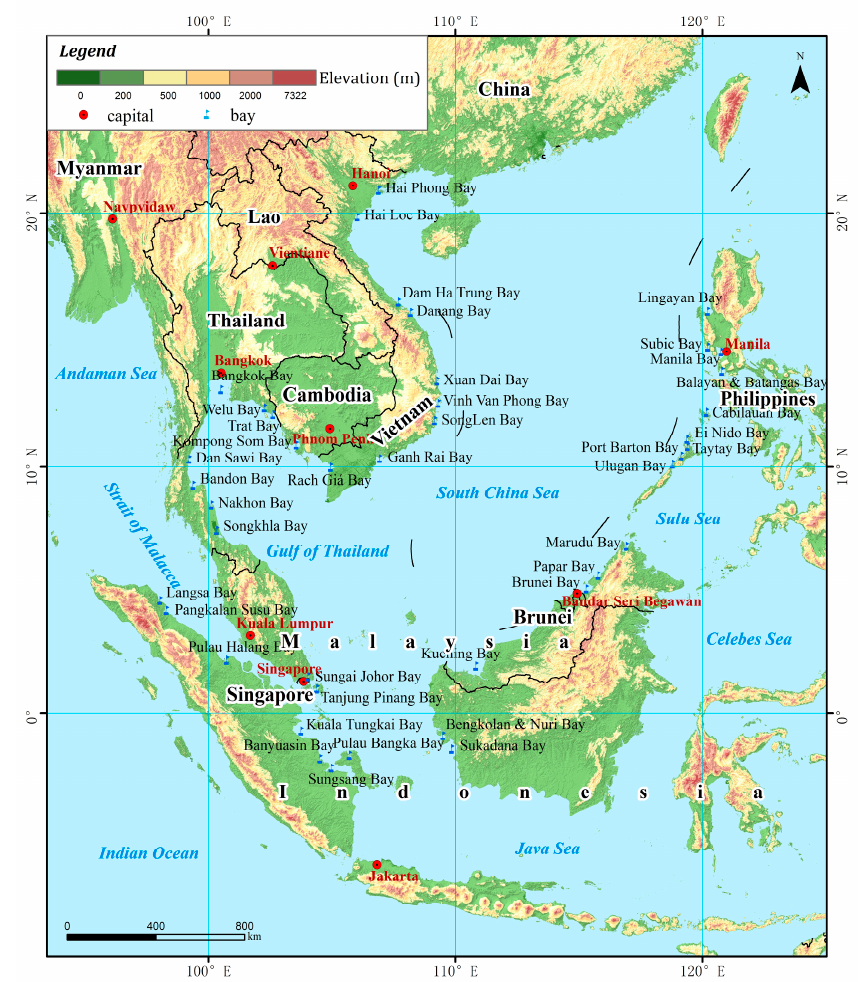
Figure 1. Location of bays surrounding the South China Sea. Table 2. Major bays surrounding the South China Sea.